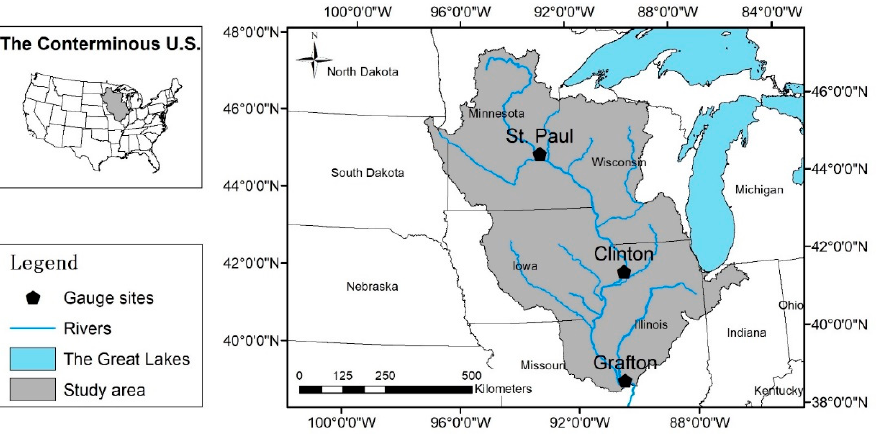
Figure 1. The location of the study area and gauge sites.